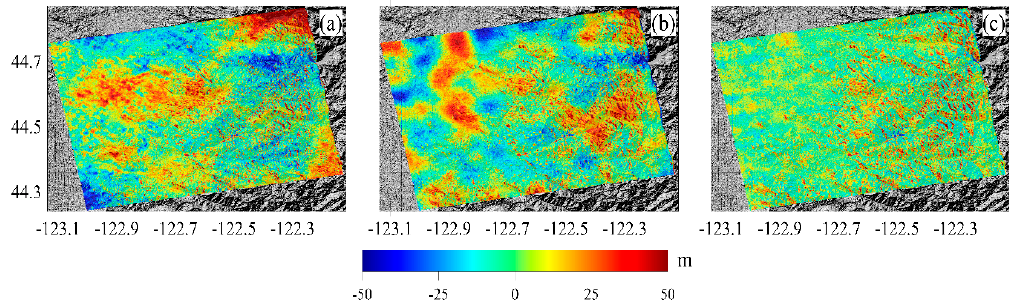
Figure 10. The elevation difference between the reference DEM and the one obtained ( a ) by the polynomial method; ( b ) by the joint correction method; and ( c ) by the proposed method in this paper.